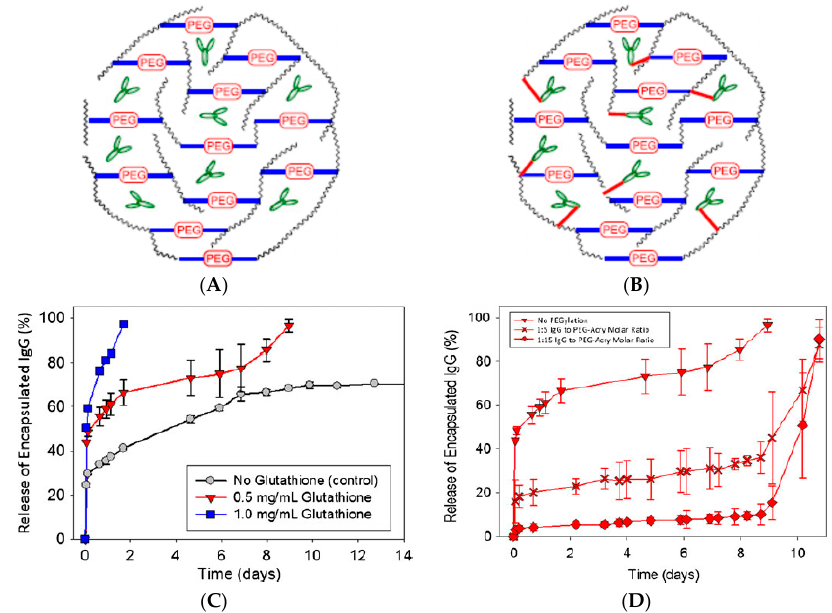
Figure 2. IgG molecules entrapped within a degradable hydrogel. ( A ) The IgG molecules are encapsulated by means of physical entrapment. ( B ) Entrapped IgG molecules are covalently linked to the hydrogel. ( C ) Release of encapsulated IgG molecules (physically entrapped) versus time. Burst release (of IgG in this case) occurs when biomolecules are encapsulated within hydrogels ( A ). ( D ) Release of encapsulated IgG molecules that were covalently linked to the hydrogel. The burst release was delayed when the antibodies were linked to the hydrogel by means of covalent bonds using bifunctional PEG molecules ( B ). Adapted and reproduced with permission from [129].